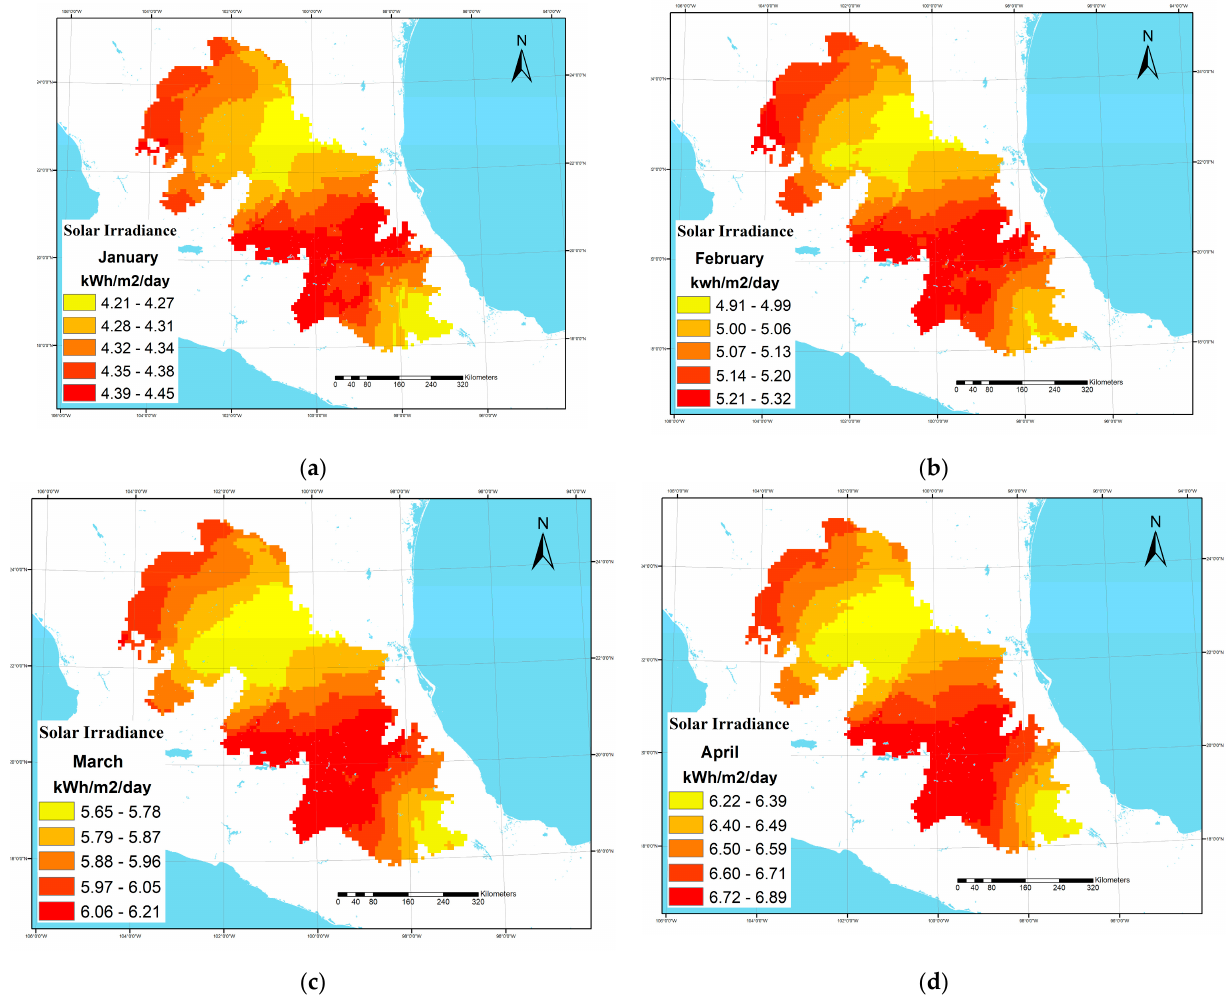
Figure 10. Average solar global irradiation in Central Mexico in ( a ) January, ( b ) February, ( c ) March, and ( d ) April.